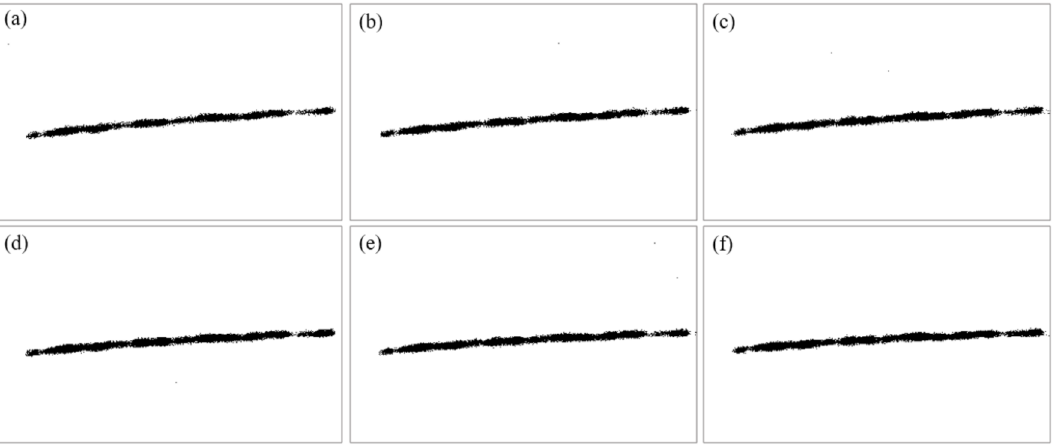
Figure 13. Some representative classified images in the first unload cycle: ( a ) 282th; ( b ) 283th; ( c ) 284th; ( d ) 285th; ( e ) 286th; ( f )